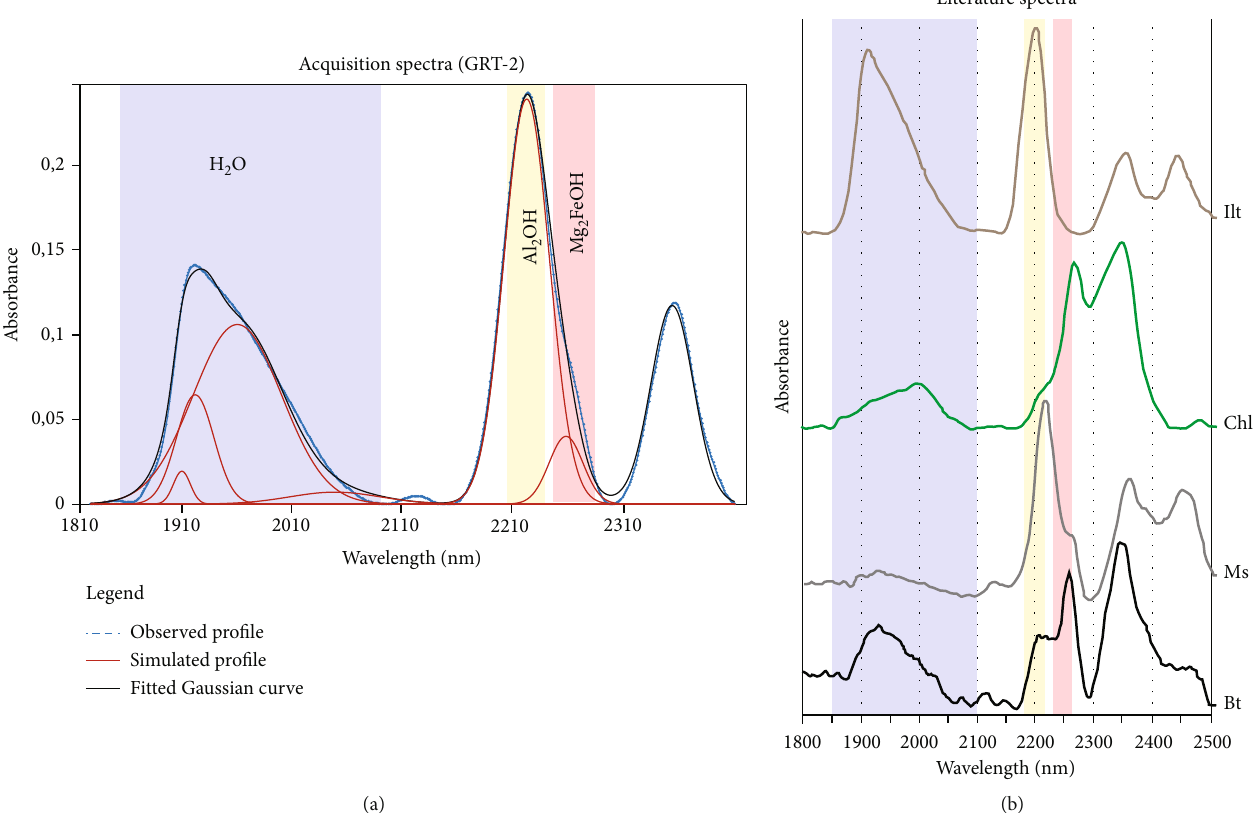
Figure 4: (a) Example of an absorption spectrum and a simulated pro fi le in the GRT-2 well at 2800 m. (b) Reference spectra from Pontual et al. [52] for biotite (Bt), muscovite (Ms), chlorite (Chl), and illite